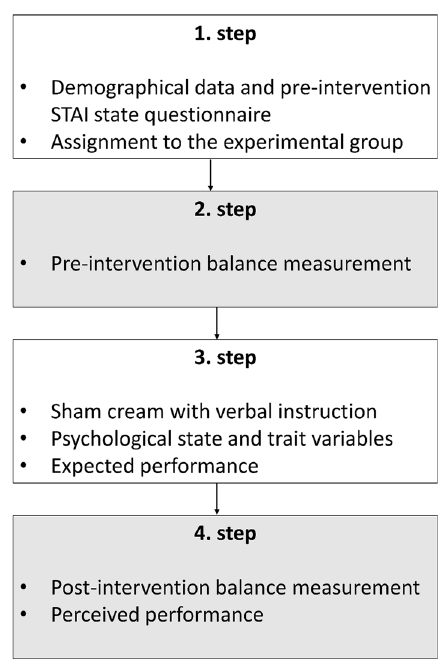
Fig. 1 Flowchart of the experiment. Note: 2. and 4. step was carried out in a separate room by a blinded